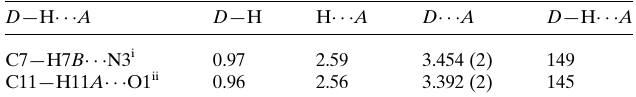
Table 1 Hydrogen-bond geometry (A˚ , (cid:2) ).